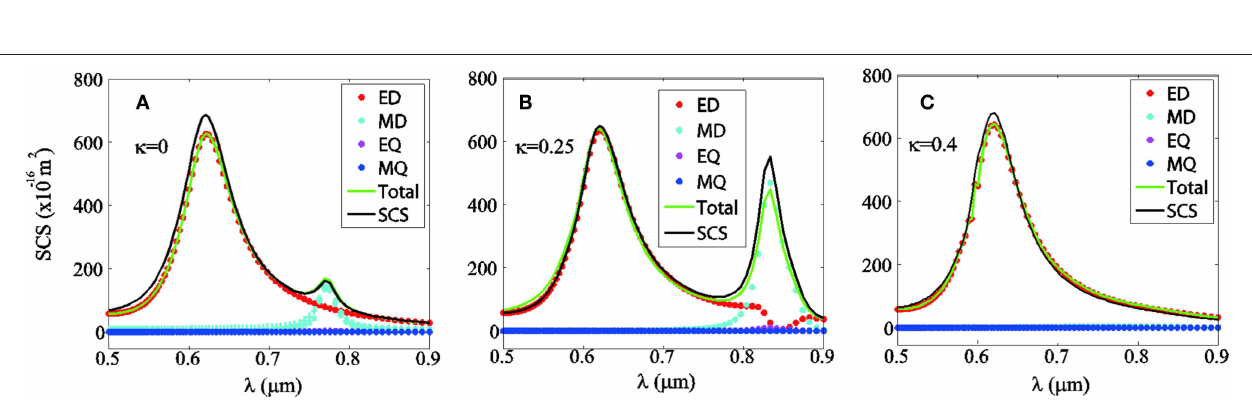
FIGURE 2 | Evolution of the multiple moments spectra for different κ of the antenna with (A) κ = 0, (B) κ = 0.25, and (C) κ = 0.4.